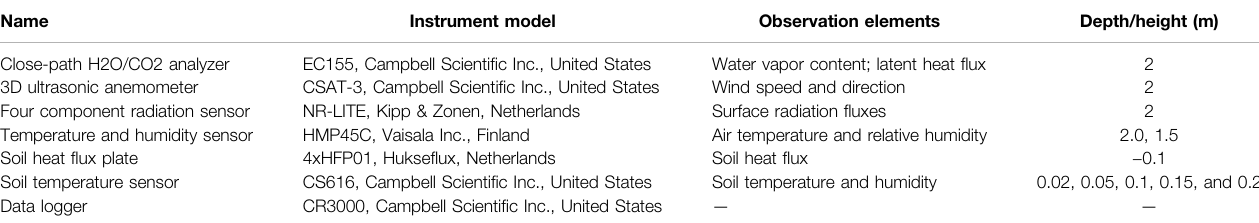
TABLE 1 | Summary of the speci fi cations of the instruments integrated on the eddy covariance fl ux tower. All measurements are averaged over 30-min